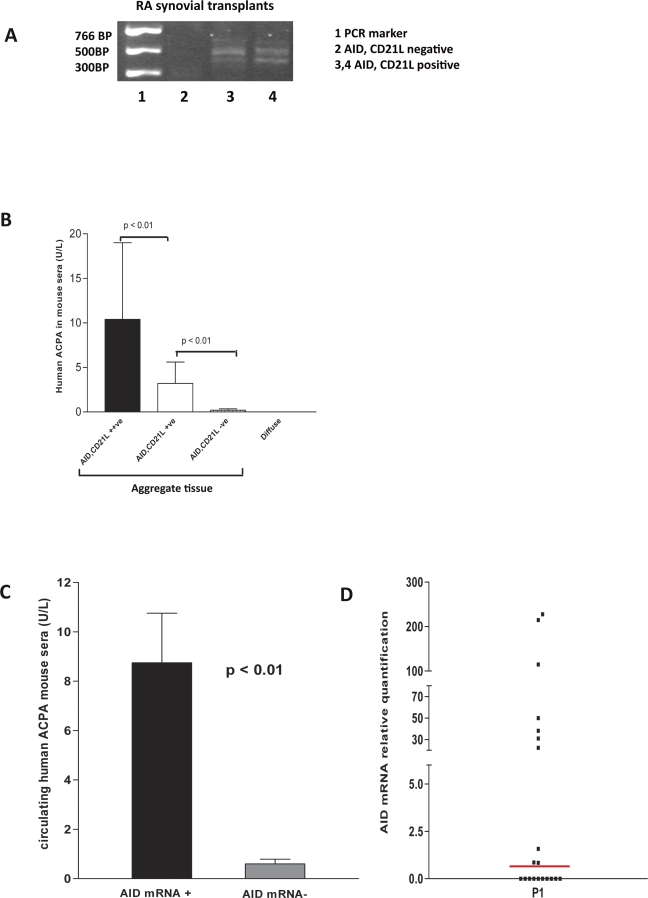
ACPA Production in the HuRA-SCID Mouse Is Associated with Functional AID Expression within Synovial GraftsSpecimens of synovium from six patients with RA were transplanted into 34 SCID mice. Four weeks post-transplantation mice were killed and all sera tested for the presence of ACPA, while mRNA from the grafts (n = 56) was reverse transcribed and used for QT-PCR to determine the number of transcripts for AID and CD21L, as well as for RT-PCR to determine the presence of circular transcripts.(A) A 1.8% agarose gel showing representative PCR products from RT-PCR performed for Iγ-Cμ circular transcripts (double bands representing alternatively spliced transcripts and confirming specificity [47]) indicating ongoing CSR in synovial grafts positive for AID/CD21L and producing ACPA (lane 3 and 4) but not in transplants negative for AID/CD21L (lane 2).(B) Synovial transplants from six RA patients were grouped according to histological classification, as aggregate versus diffuse, and activation-induced cytidine deaminase, CD21L mRNA expression as high (++), low (+), and negative (−). Significantly higher levels of anti-citrullinated protein/peptide antibodies were seen in those mice transplanted with synovium expressing high mRNA levels of AID/CD21L. Notably, ACPA were not seen in the absence of AID.(C and D) To establish the relationship within the same patient between levels of AID expression and ACPA production, synovial grafts from an illustrative patient (P1) were stratified according to the presence or absence of AID as determined by QT-PCR (D) (horizontal line indicates cut off for positivity). Circulating ACPA from synovial grafts were produced at a significantly higher level in AID+ compared to AID− grafts. Error bars indicate mean levels of ACPA + SD. p-Values were calculated using Kruskal-Wallis test (B) and Mann Whitney U test (C).